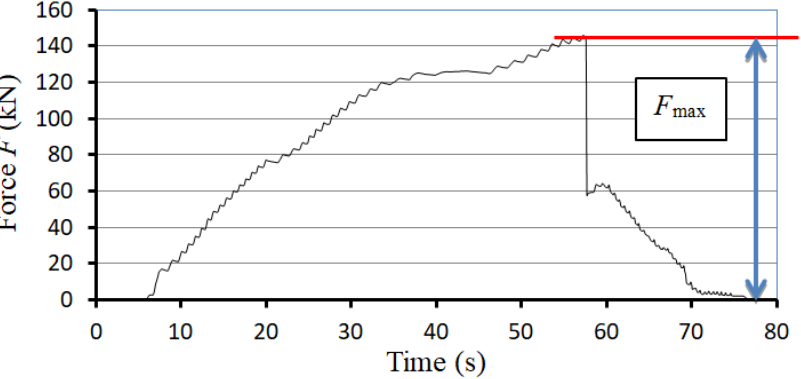
, recorded during the loosening max